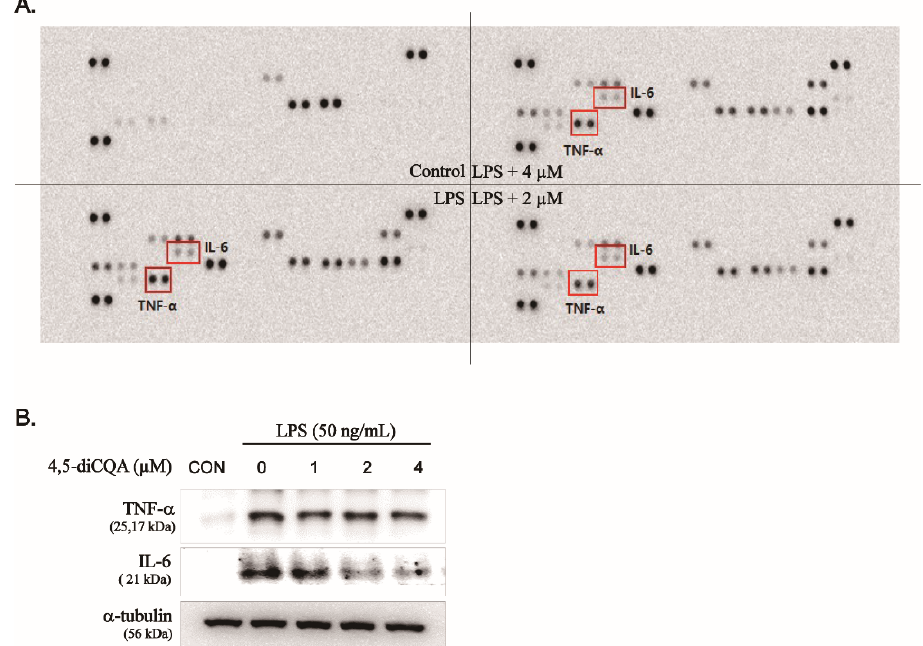
Figure 3. Inhibitory effect of 4,5-diCQA on LPS-induced TNF- α and IL-6 in RAW264.7 cells-stimulated with LPS. Cells were pretreated with 4,5-diCQA (1, 2, and 4 µM) for 1 h, followed by LPS (50 ng/mL) stimulation for 24 h. ( A ) TNF- α and IL-6 were determined in the cultured medium using mouse cytokines array. ( B ) Expression of TNF- α and IL-6 was determined using Western blot analysis. α -Tubulin served as an internal control. CON; control, TNF- α ; tumor necrosis factor-alpha, IL-6; interleukin-6.